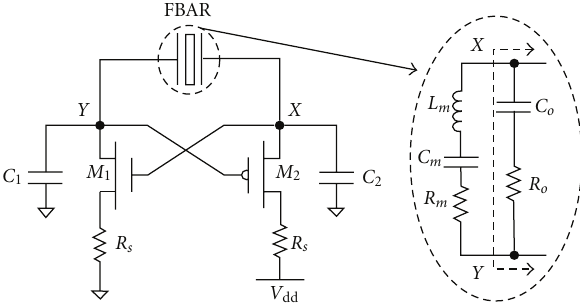
Figure 4: Schematic of the FBAR oscillator and equivalent circuit of FBAR.